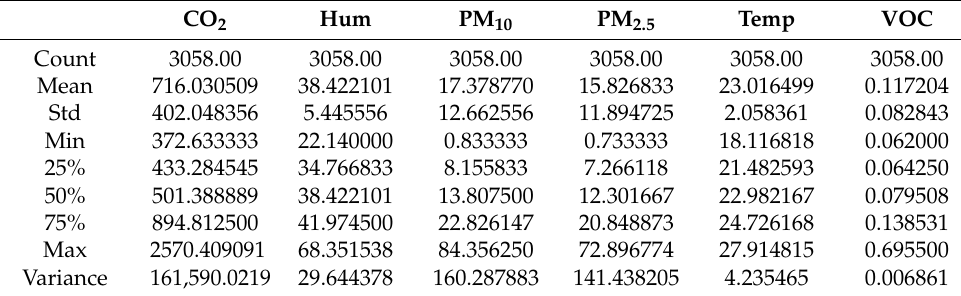
Table 8. Statistical information of pre-processed GAMS Dataset.